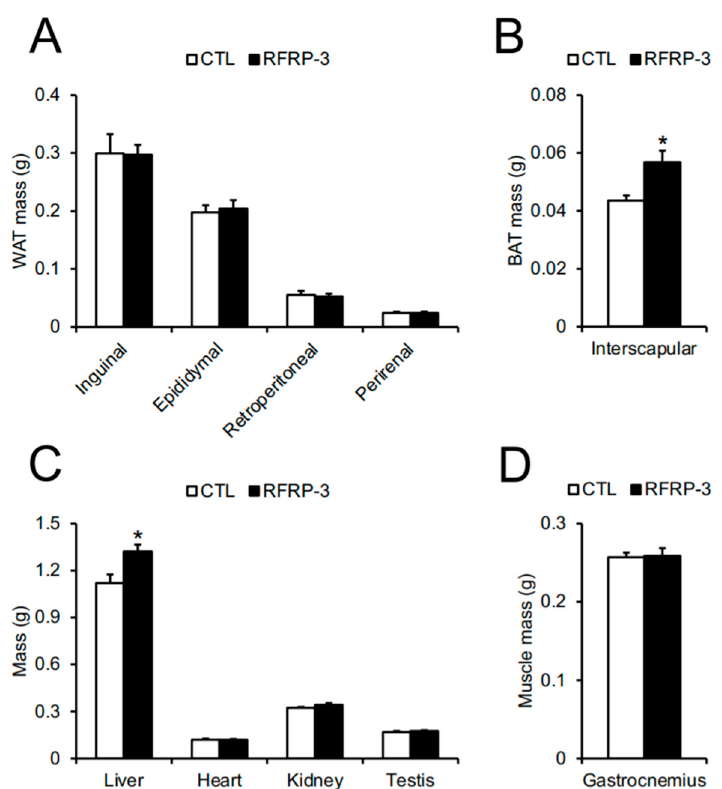
Figure 2. The effects of chronic intracerebroventricular (i.c.v.) infusion of RFamide-related peptide-3 (RFRP-3) on body composition. ( A ) Inguinal, epididymal, retroperitoneal, and perirenal white adipose tissue (WAT) mass. ( B ) Interscapular brown adipose tissue (BAT) mass. ( C ) Liver, heart, kidney, and testis mass. ( D ) Gastrocnemius muscle mass. Each value represents the mean ± standard error of the mean. n = 7–8; * p < 0.05.